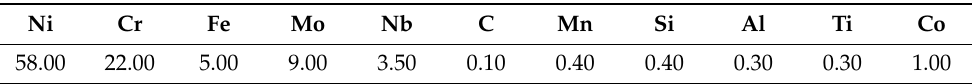
Table 1. Nominal chemical composition of the Inconel 625 (wt.